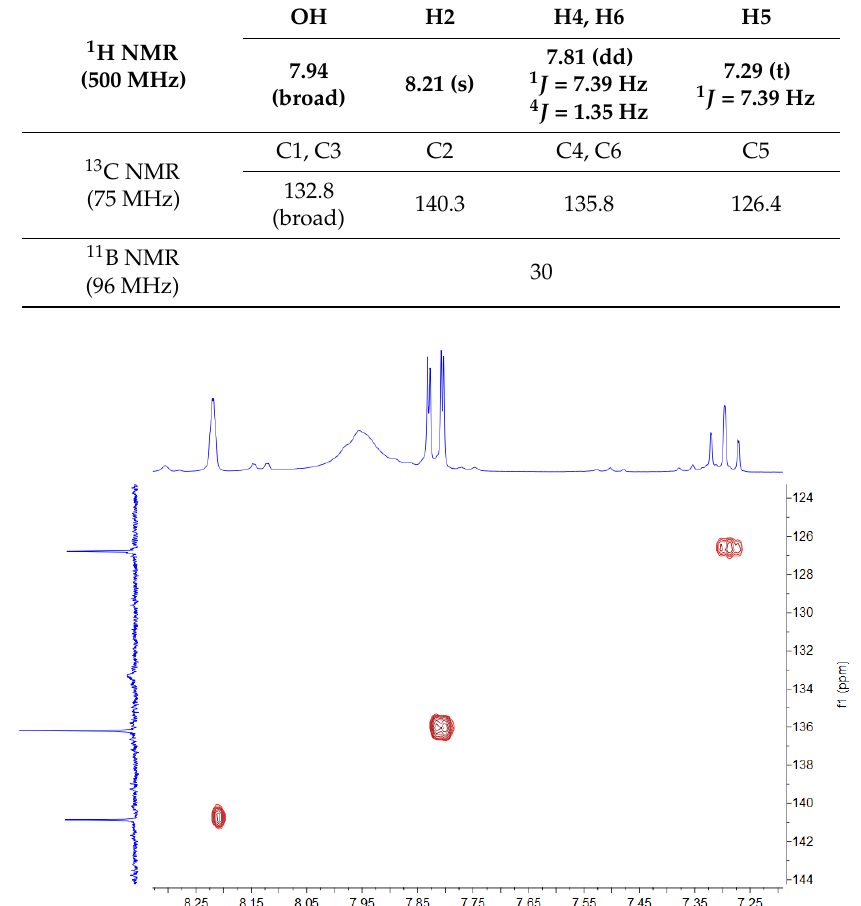
Figure 2. 1 H- 13 C HSQC spectrum of the title compound. Table 2. Chemical shifts (ppm) and coupling constants ( J ) for 1,3-phenylenediboronic acid in DMSO- d 6 atom numbering scheme shown at Figure 3.